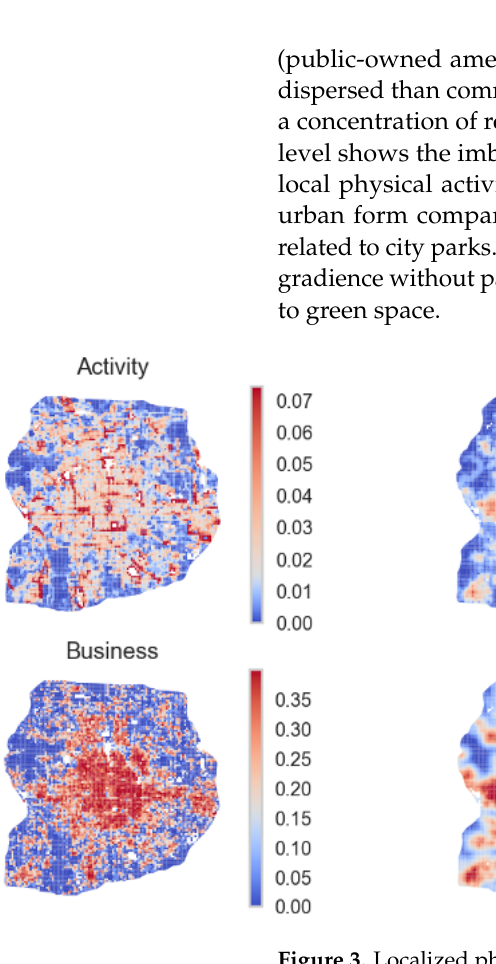
Figure 3. Localized physical activity and vibrancy estimation based on 1 square kilometer grid.